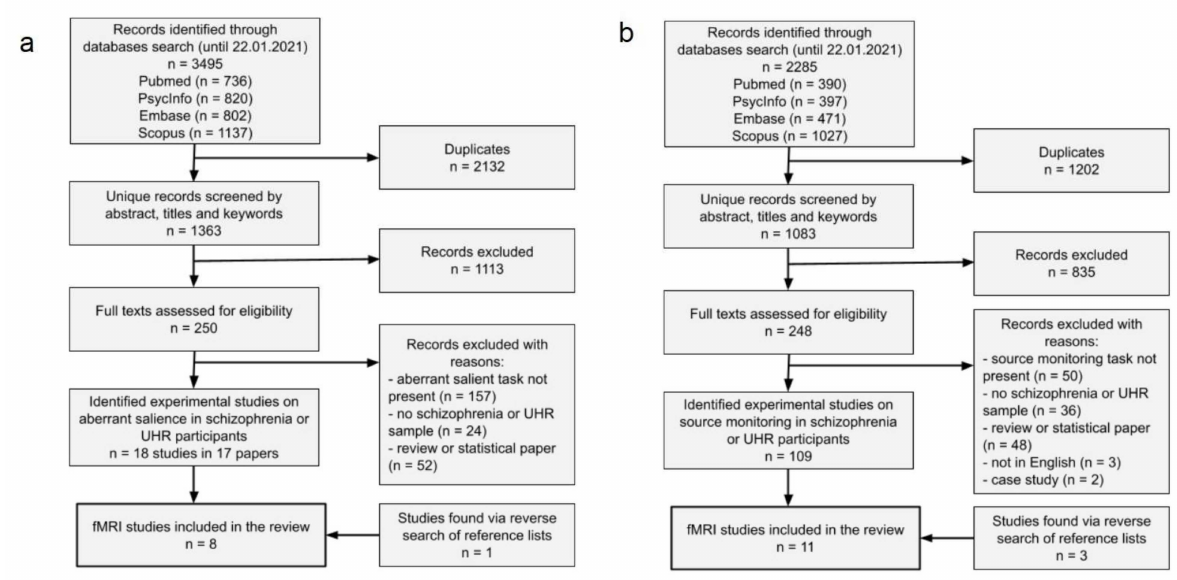
Figure 1. Flow diagram of literature search and review for aberrant salience ( a ) and source monitoring ( b )